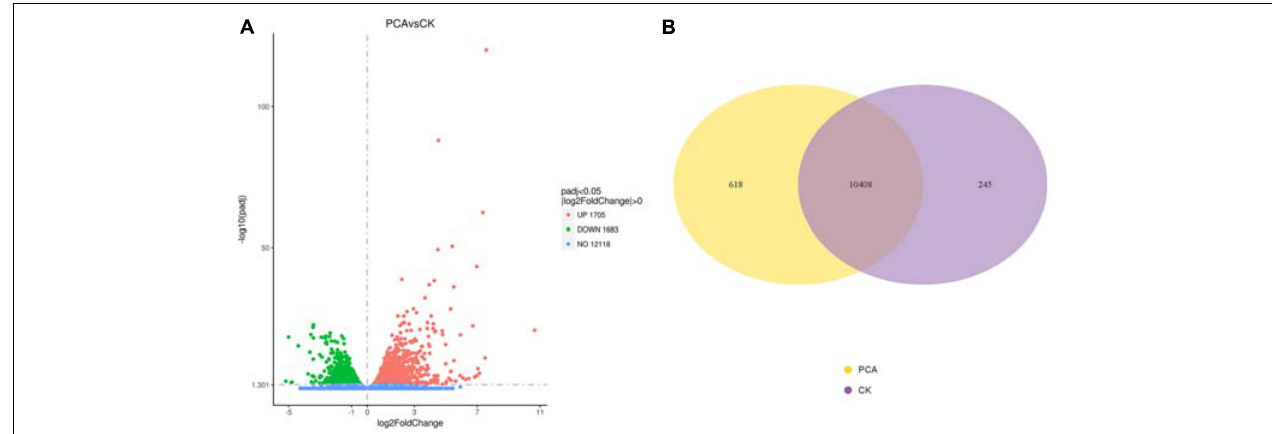
FIGURE 5 | Differentially expressed genes (DEGs) of Ps. camelliae-sinensis strain GZHS-2017-010 between PCA-treated hyphae vs. CK-treated hyphae. (A) Volcano map of DEGs. In the sub-figure, the x -coordinate is log2FoldChange value and the y -coordinate is -log10padj; (B) Venn diagram of DEGs.